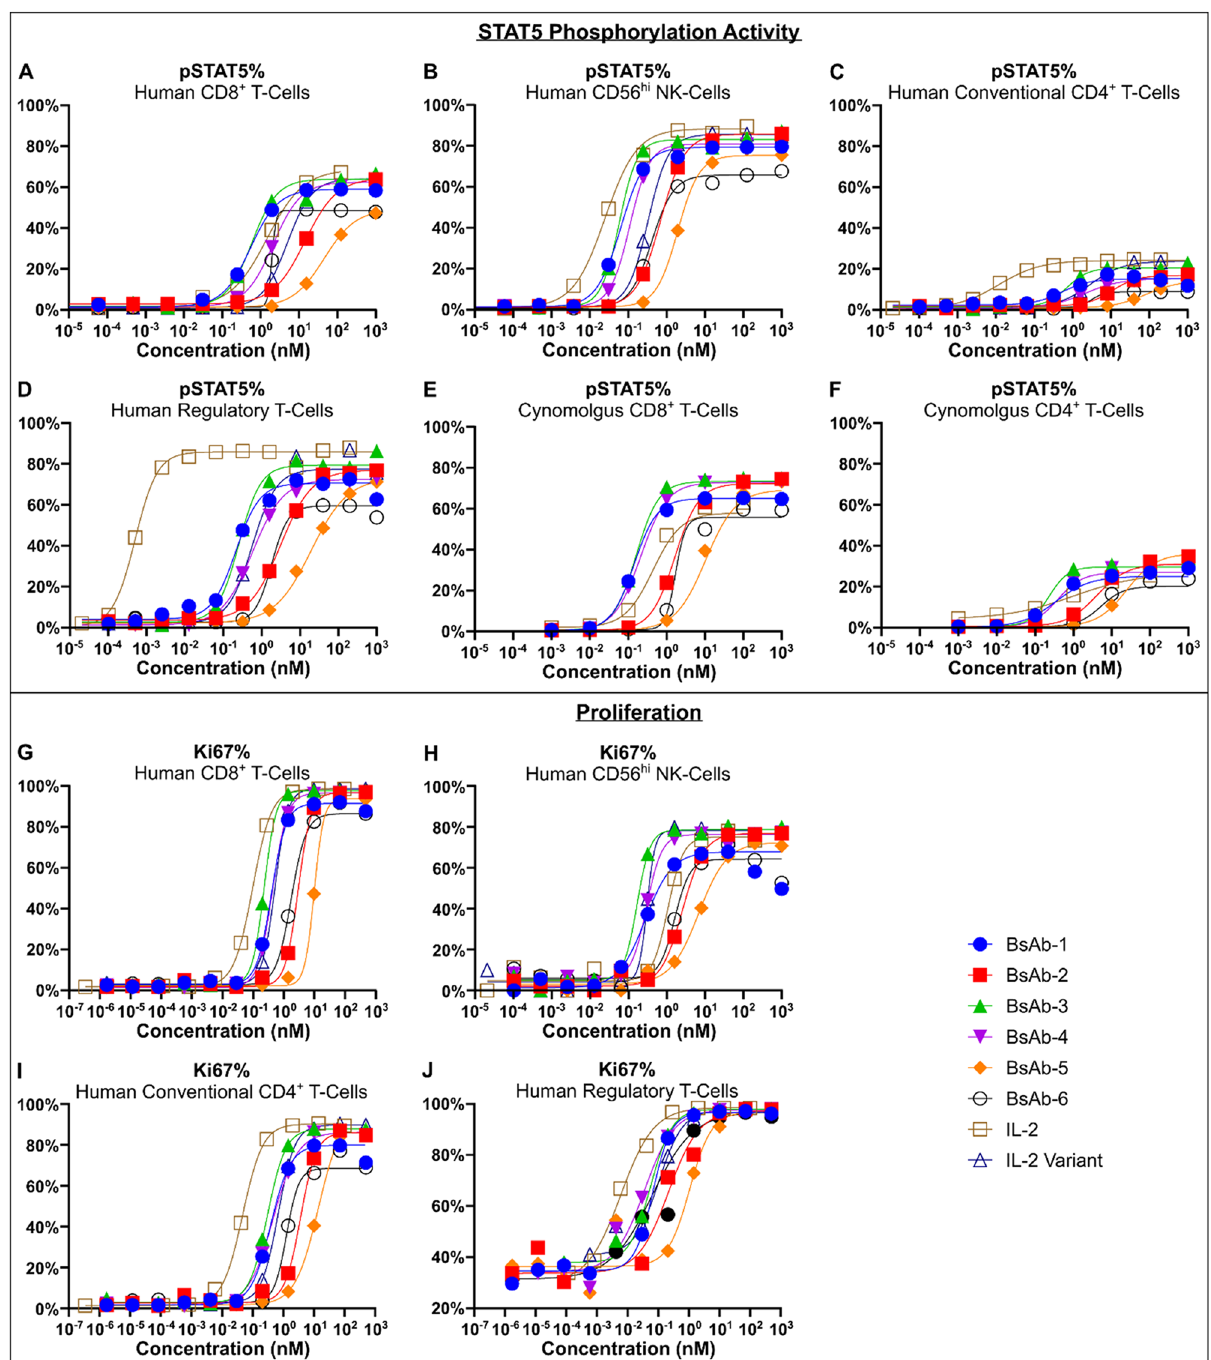
Figure 2. IL-2Rβγ bispecific UniAbs induce proliferation and STAT5 phosphorylation in PBMCs. ( A to F ) pSTAT5 dose curves for human CD8 + T-cells ( A ), CD56 hi NK-cells ( B ), CD4 + Conventional T-cells ( C ), CD4 + Regulatory T-cells ( D ), cynomolgus CD8 + T-cells ( E ), and total CD4 + T-cells ( F ). pSTAT5 levels were determined by flow cytometry and were reported as a percentage of the indicated cell type. ( G to J ) Ki67 dose curves for human CD8 + T-cells ( G ), CD56 hi NK-cells ( H ), CD4 + Conventional T-cells ( I ), CD4 + Regulatory T-cells ( J ). Ki67 levels were determined by flow cytometry and were reported as a percentage of the indicated cell type. CD4 + Conventional T-cells are defined here as CD3 + CD4 + Foxp3 - . CD4 + Regulatory T-cells are defined here are CD3 + CD4 + CD25 + Foxp3 +